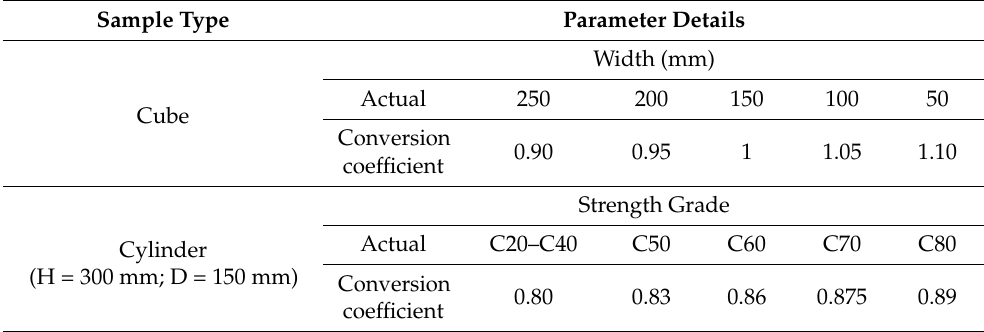
Table 2. Compressive strength conversion